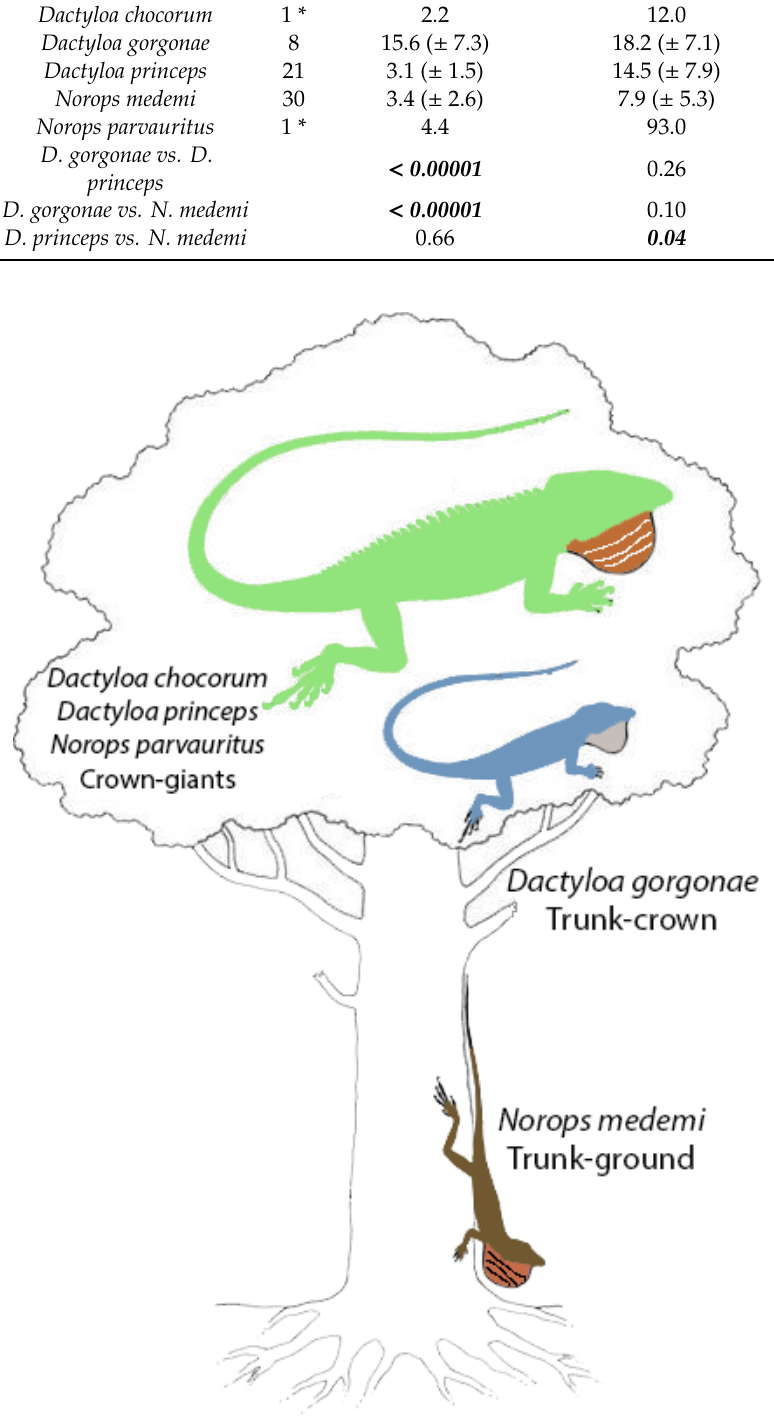
Figure 6. The Isla Gorgona anole community depicted by habitat in accordance with ecomode designation by Nicholson et al. [21]. Figure modified from [13], which was modified from [78].